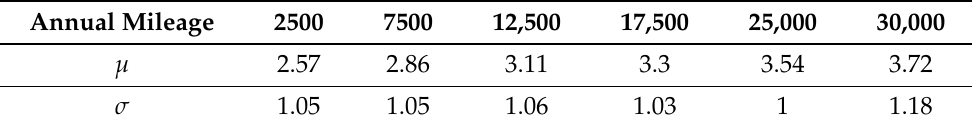
Figure 2. Daily mileage frequency for different values of µ and σ . Table 1. Mean value µ and standard deviation σ of daily mileage log_norm